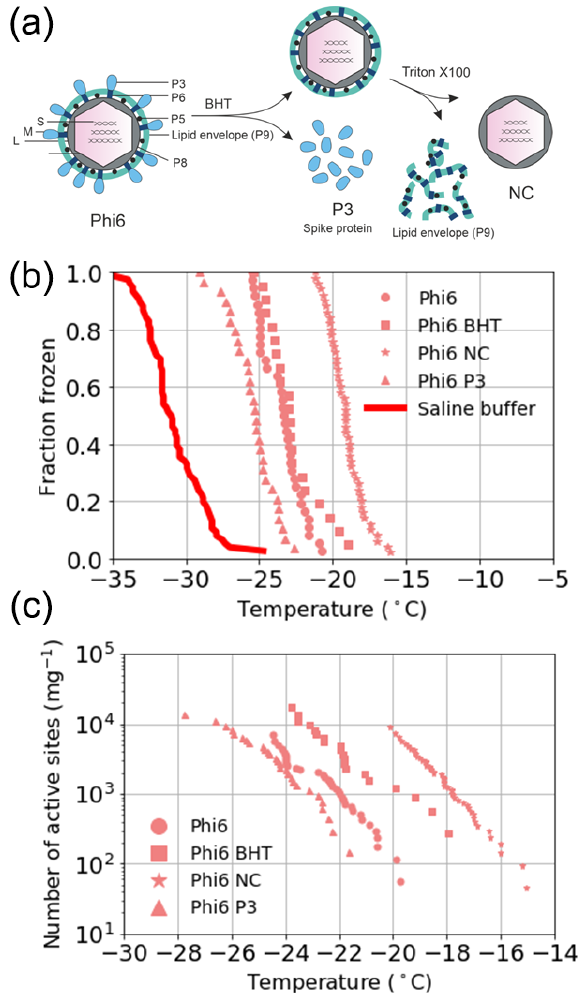
Figure 2. Ice nucleation activity of the sub-viral particles of the Phi6 virus. (a) Biochemical dissociation of the Phi6 virion. Small genome fragment is marked as S, medium genome fragment as M and large genome fragment as L; P3 is the spike protein, P5 is the lytic enzyme, P6 is the membrane fusion protein, P8 is the outer capsid lattice protein and P9 is the major envelope protein; BHT means butylated hydroxyl toluene; NC is the nucleocapsid. (b) Fraction frozen curves for Phi6 and its sub-viral components. These values have not been correct for freezing point depression due to NaCl. (c) The INA (expressed as active sites per unit mass, n m ) of Phi6 and its sub-viral components normalized to the mass of particle per volume of suspension. Phi6 BHT in panels (b) and (c) refers to spikeless enveloped icosahedral structure. Temperature values have been corrected for freezing point depression of NaCl.